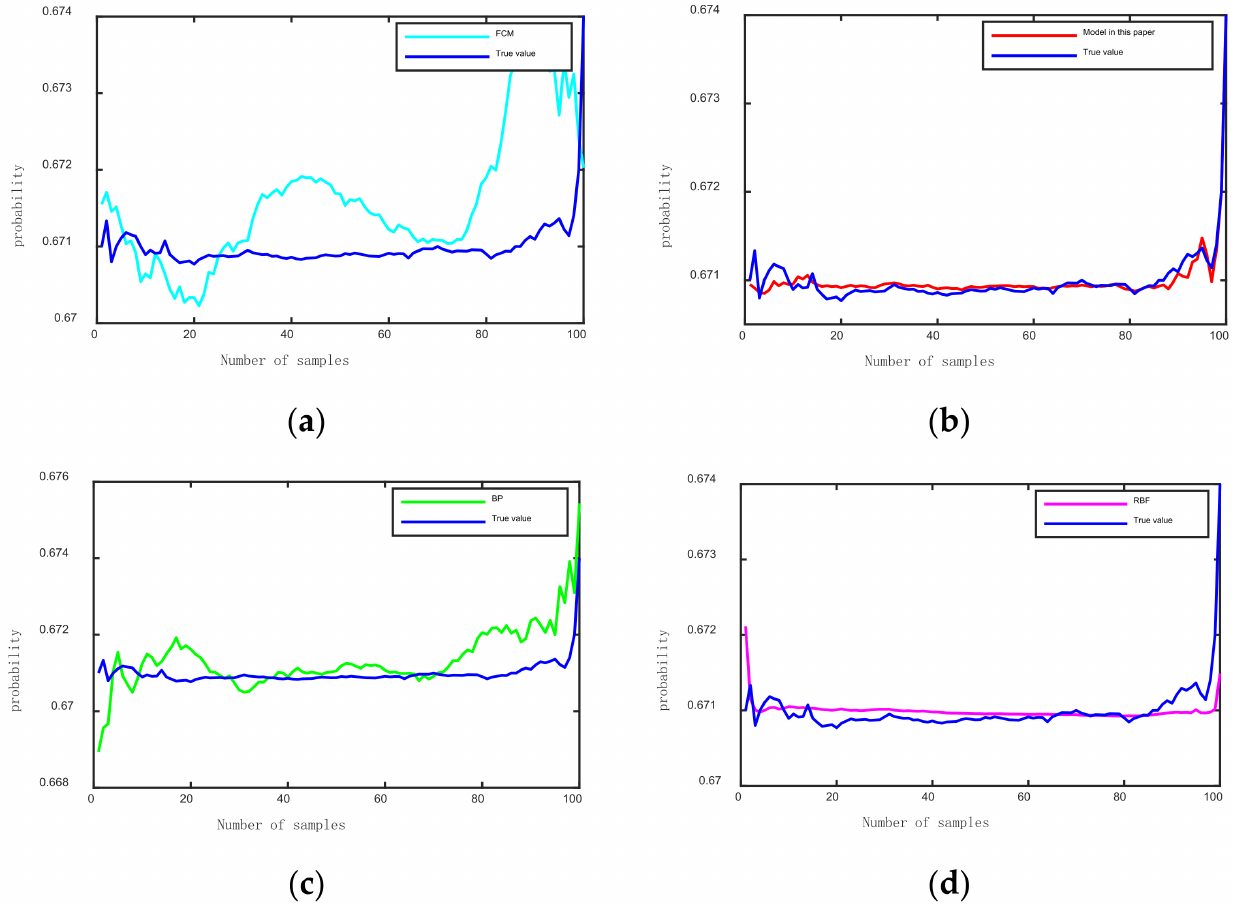
Figure 10. Comparison of this model with other methods. ( a ) Comparison chart of FCM method and real value. ( b ) The comparison chart of the model and the real value in this paper. ( c ) Comparison chart of BP neural network and real value. ( d ) Comparison chart of RBF method and real value. The specific mean square error value is shown in Figure 11